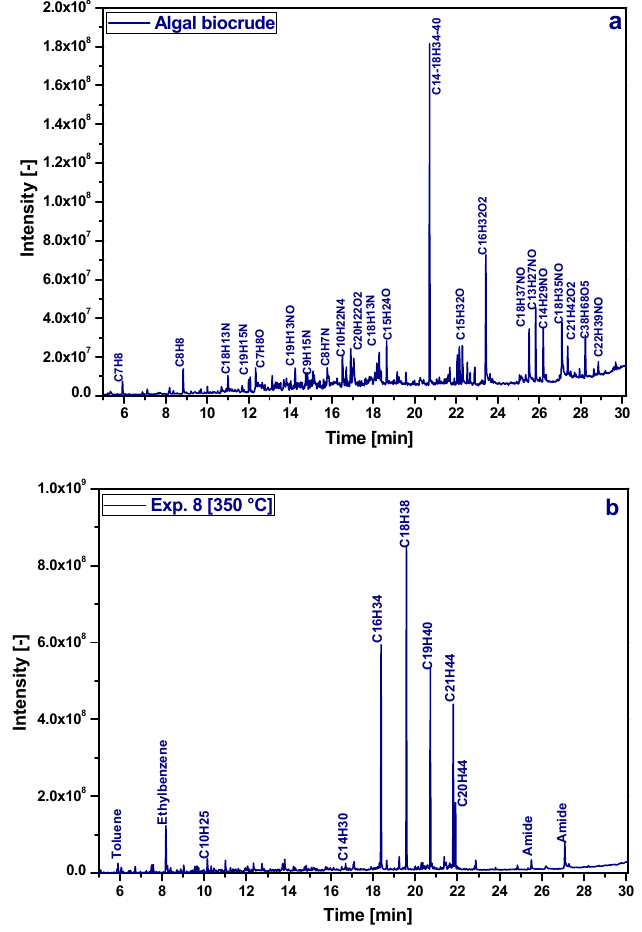
Figure 3. GC-MS chromatographs of ( a ) bio crude and ( b ) Experiment 8 at 350 °C.